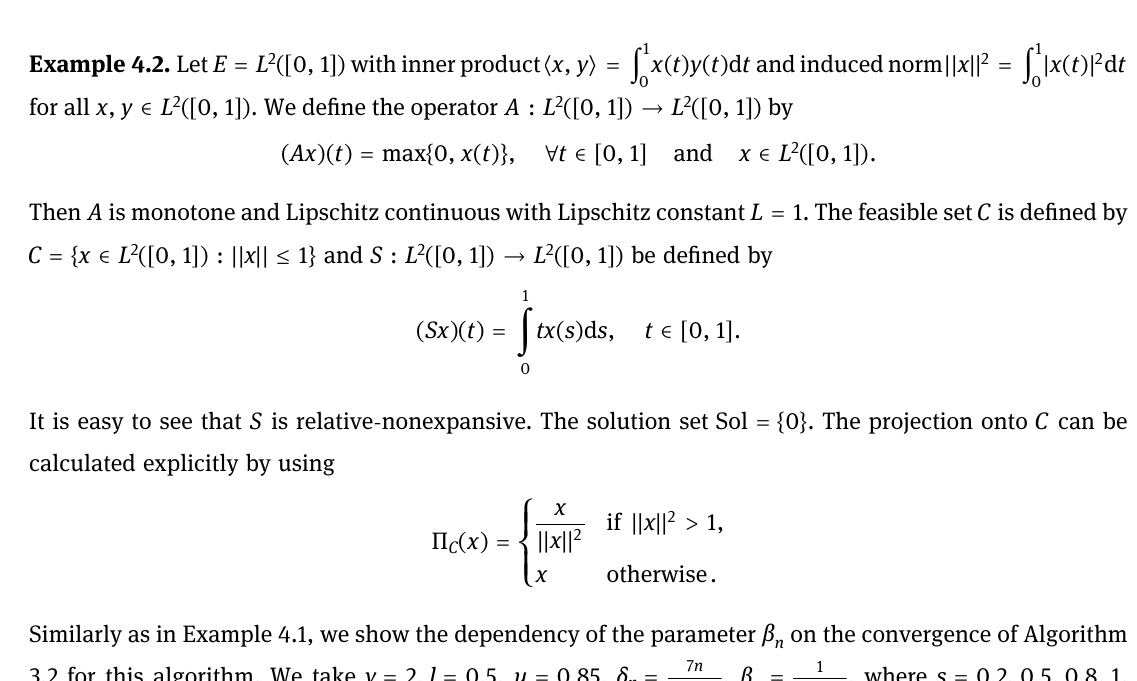
Algorithm 3.2 Algorithm (1.4)